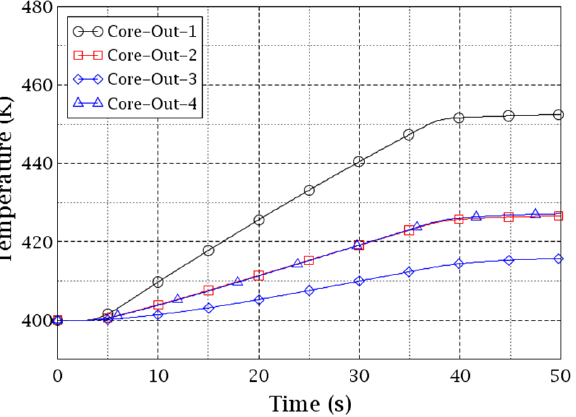
Figure 14. Evolution of the coolant temperature distribution at the core inlet CA-V (cell index is from Figure 10).